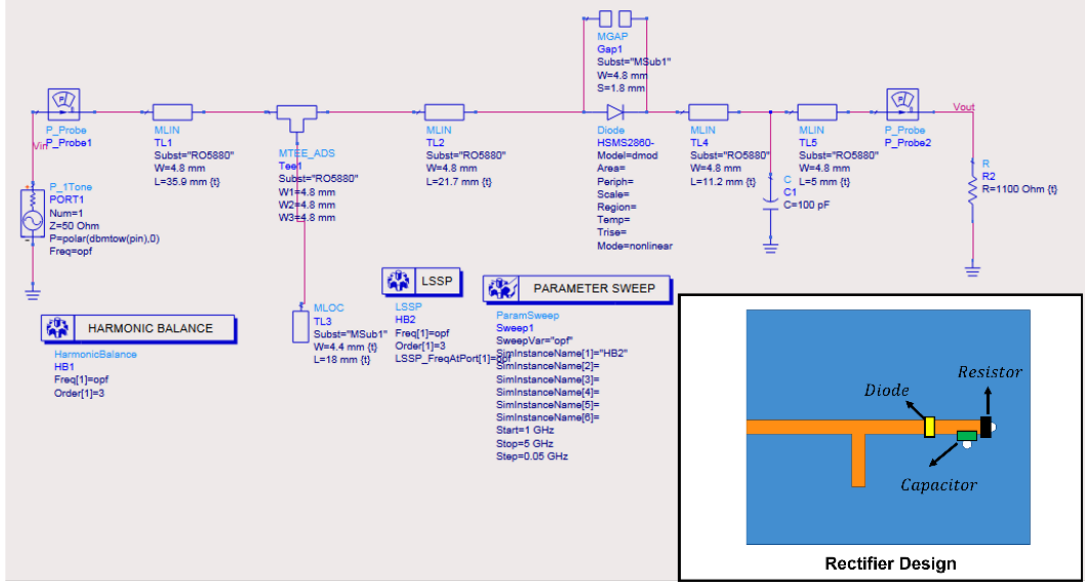
Figure 6. ADS schematic of the rectifier circuit.